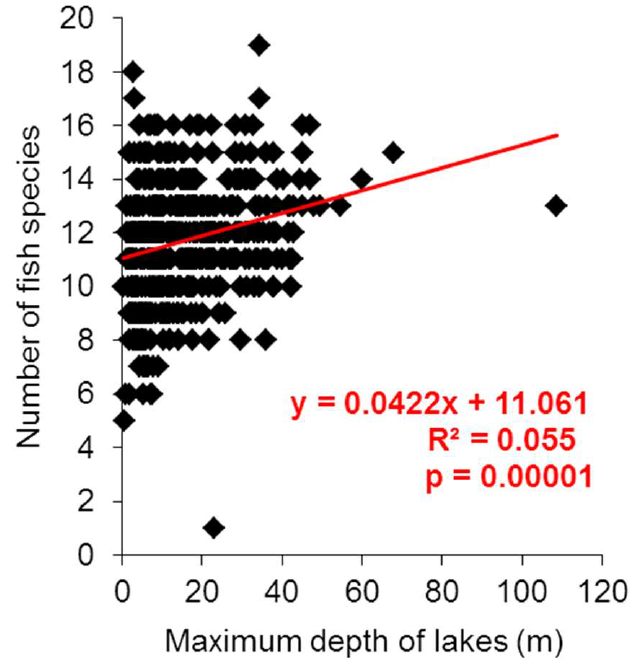
Figure 6. The relationship between the maximum depth of lakes and the number of fish species in 535 Polish lakes.